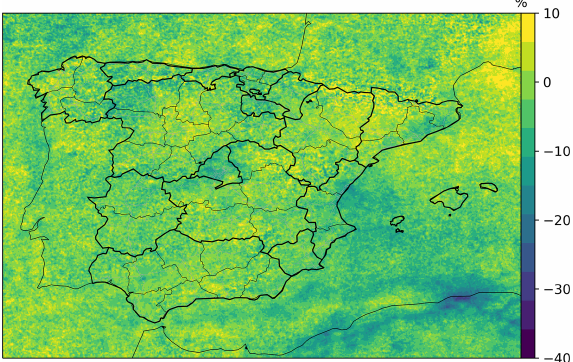
Figure G5. Mean relative change of TROPOMI TrC-NO 2 on Friday–Saturday (which corresponds to the occidental “weekend” in Algeria), relative to the other days (Monday–Tuesday–Wednesday–Thursday–Sunday). Note that weekends in Morocco are similar to Spain.